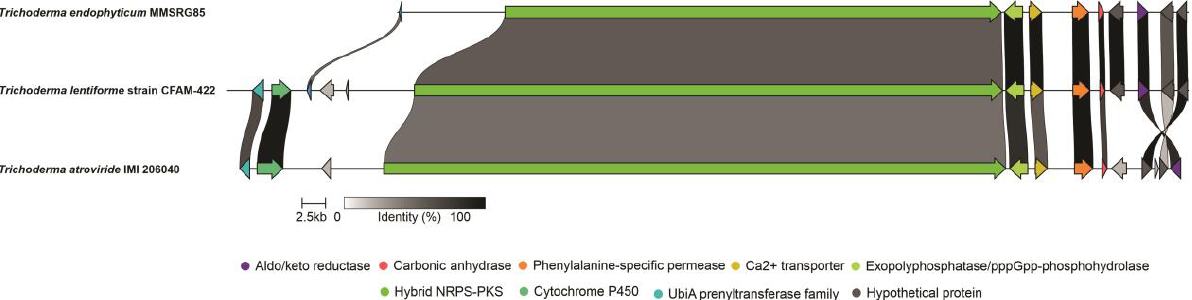
Figure 3. Synteny analysis between BGC 19.1 encoding a PKS-NRPS of 15 modules of Trichoderma endophyticum strain MMSRG85 and the BGC containing the TEX1 gene related to the biosynthesis of 18-res peptaibols in Trichoderma atroviride IMI 206040 and a putative peptaibol synthetase of Trichoderma lentiforme . The synteny analysis shows conserved genes among the BGCs related to the production of peptaibols from T. endophyticum strain MMSRG85 (15 modules), Trichoderma lentiforme (18 modules) and Trichoderma atroviride (19 modules), revealing that the loss or gain of modules in these NRPSs may favor the diversity of the peptaibols produced (Figure